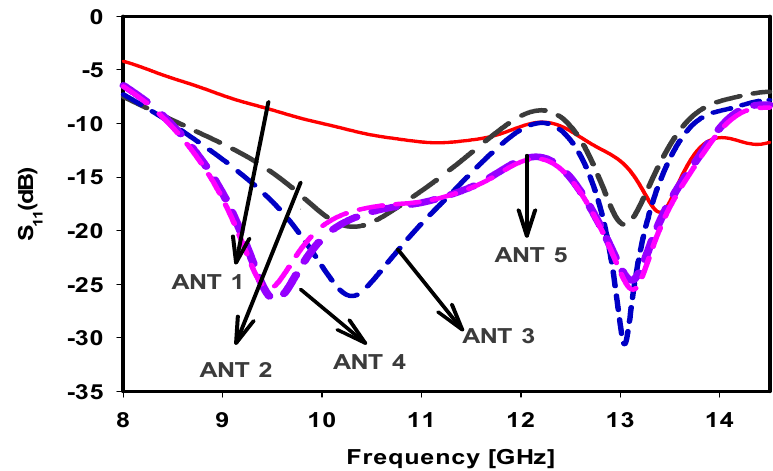
Figure 3. Reflection coefficients for the different steps of the proposed design.